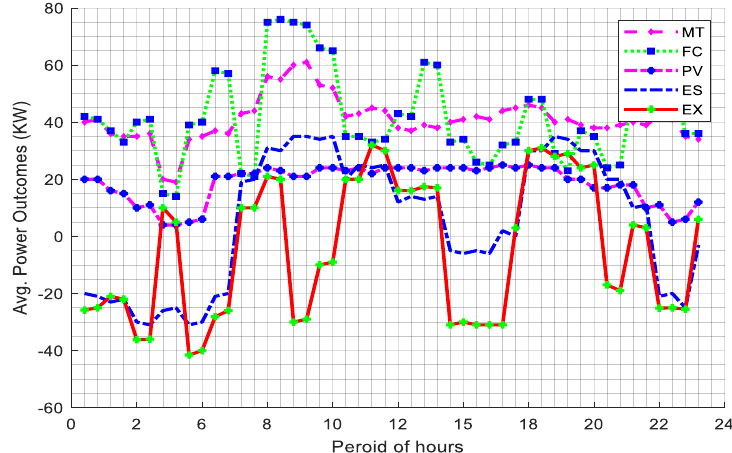
Figure 13. The production graphs of grid-connected and microgrid subsystem power supplies in daily cycle load.